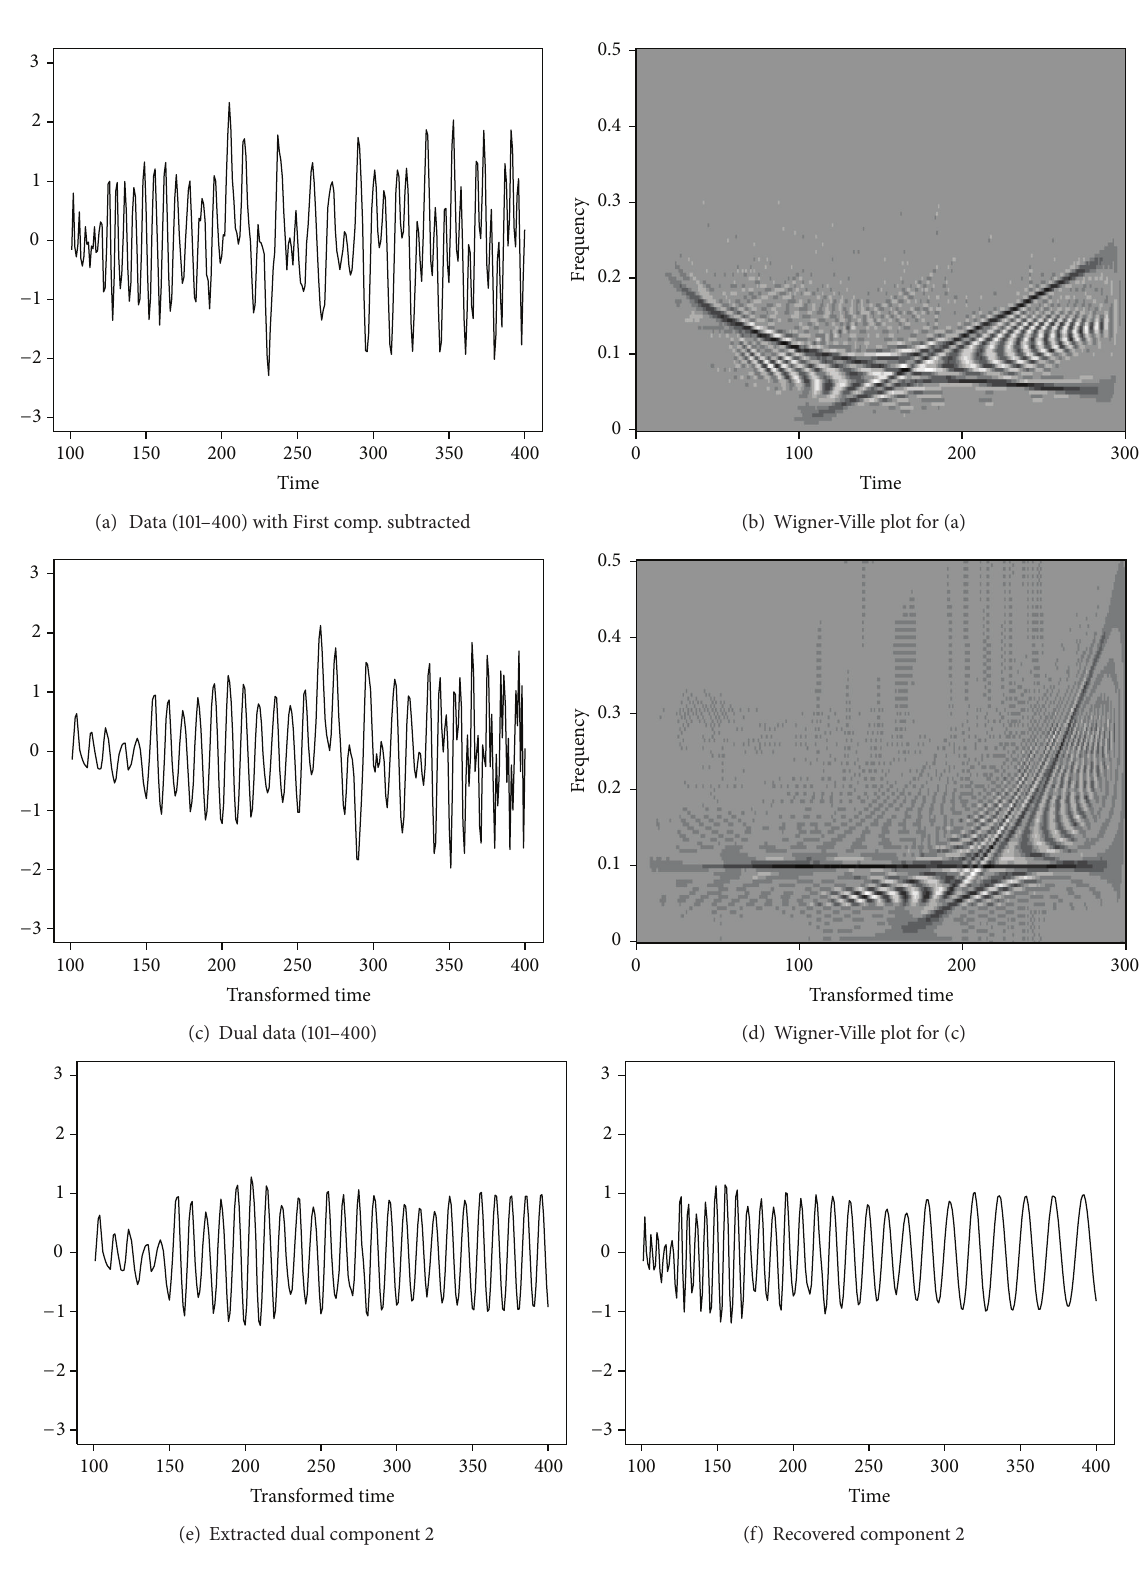
Figure 10: (a) The data (101:400) with the first filtered component subtracted; (b) the Wigner-Ville time-frequency distribution of the data; (c) the dual data; (d) the Wigner-Ville time-frequency distribution of the dual; (e) the extracted stationary dual component; (f) the recovered 𝑀 -stationary